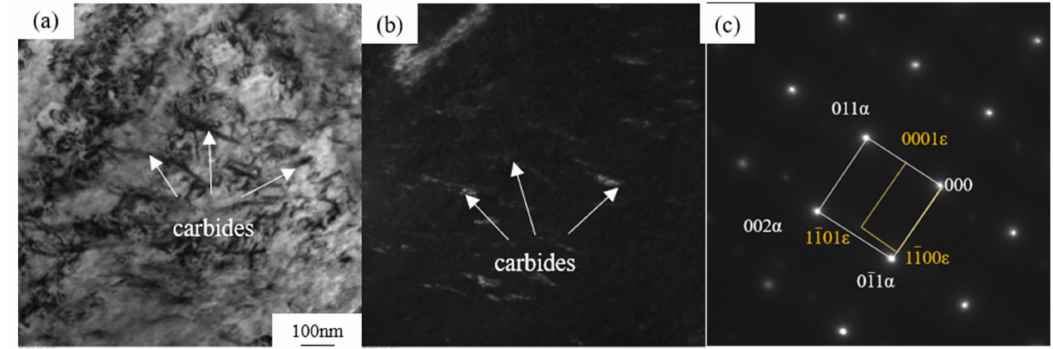
Figure 7. TEM analysis of steel B heated at 880 ◦ C for 3 min, soaked at 200 ◦ C for 30 min then air-cooled. ( a ) bright field TEM image and ( b ) dark field TEM image and ( c ) corresponding SAED pattern of lath martensite and ε -carbides.